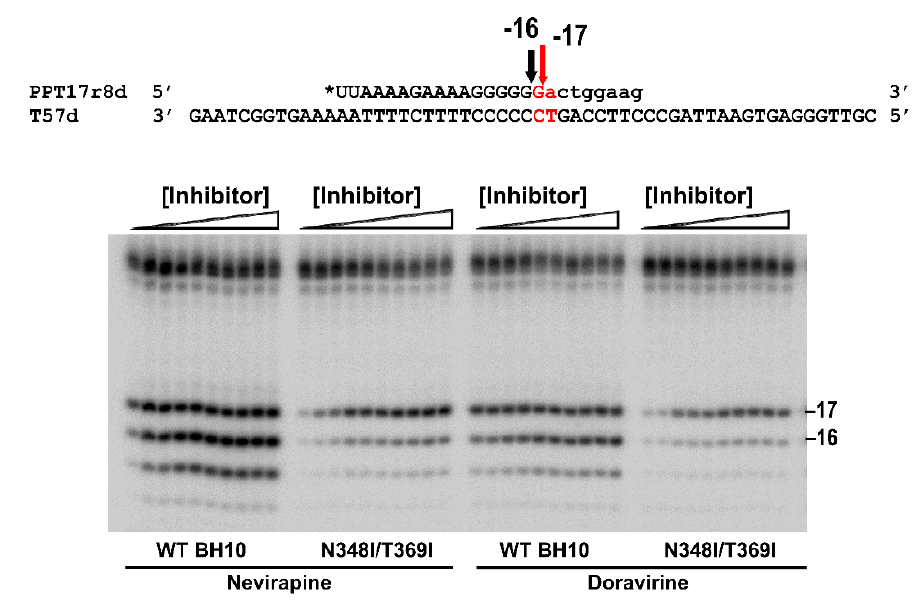
Figure 3. Cleavage of the chimeric PPT(RNA)-DNA oligonucleotide in the T57d/PPT17r8d complex in the presence of increasing concentrations of nevirapine and doravirine by WT HIV-1 BH10 RT and mutant N348I/T369I. In each experiment the NNRTI concentrations used were 0, 0.08, 0.16, 0.3125, 0.625, 1.25, 2.5, 5, 10 and 20 µM. Template-primer and RT concentrations in these assays were 25 and 125 nM, respectively. Aliquots were withdrawn after a 20 s-incubation. Experiments were carried out twice and a representative gel is shown. Arrow and text in red indicate the location of the PPT/U3 cleavage site.